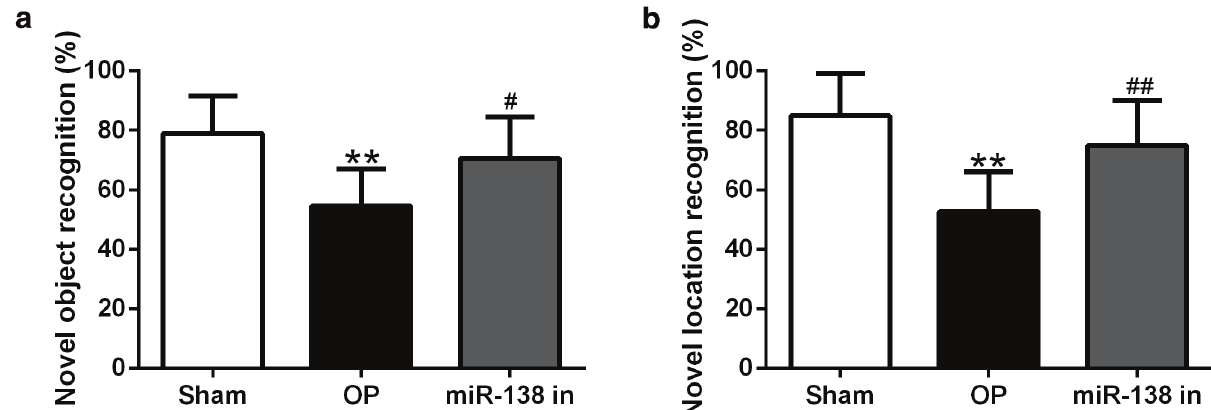
Fig. 2. Inhibition of miR-138-5p increased novel object and novel location recognition after cardiac surgery induced postop- erative cognitive dysfunction (POCD) in mice. (a) Novel object recognition in the novel object test. (b) Spatial recognition in the novel location test. Sham: C57BL/6 wild-type mice with sham cardiac surgery; OP: C57BL/6 wild-type mice with cardiac surgery. miR-138 in: C57BL/6 wild-type mice with cardiac surgery treated with miR-138-5p inhibitors. Data were presented as ± SD. ** P < 0.01 compared to sham group. # P < 0.05, ## P < 0.01 compared to OP group. n = 8 for each